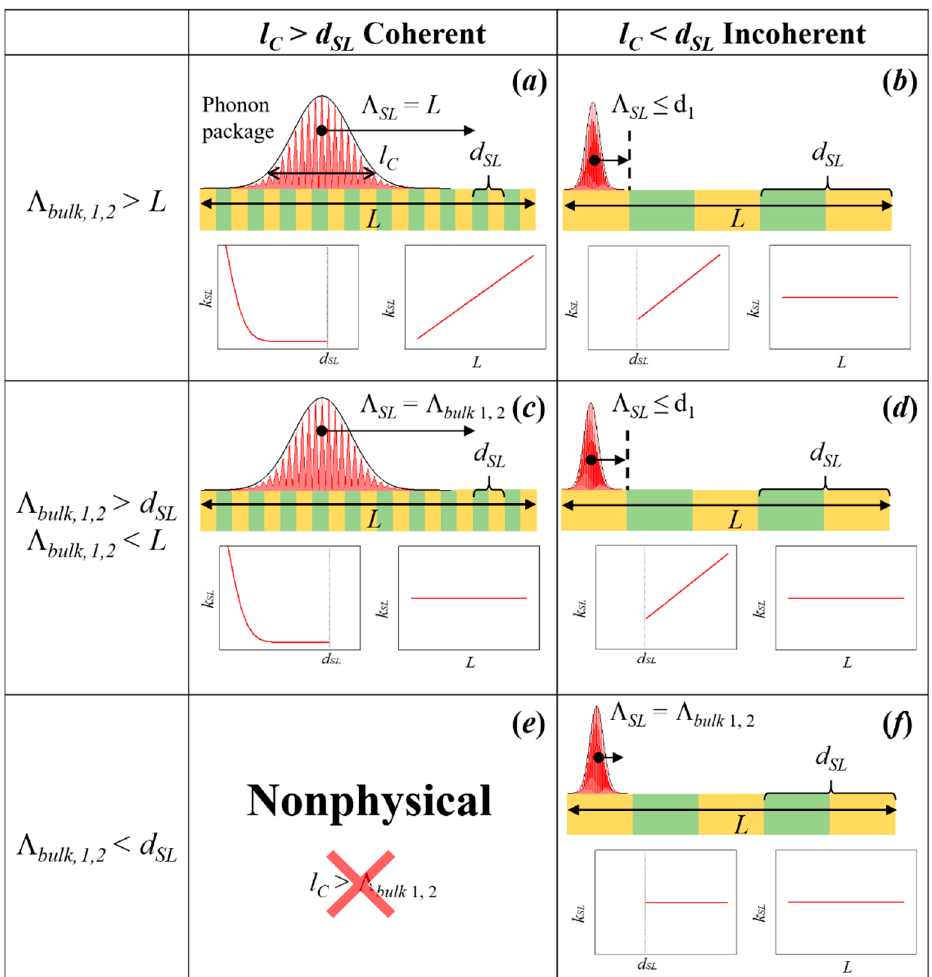
Figure 4. ( a – f ) Schematic representation of coherent and incoherent thermal transport in superlattices (adapted from Latour et al. [42]).